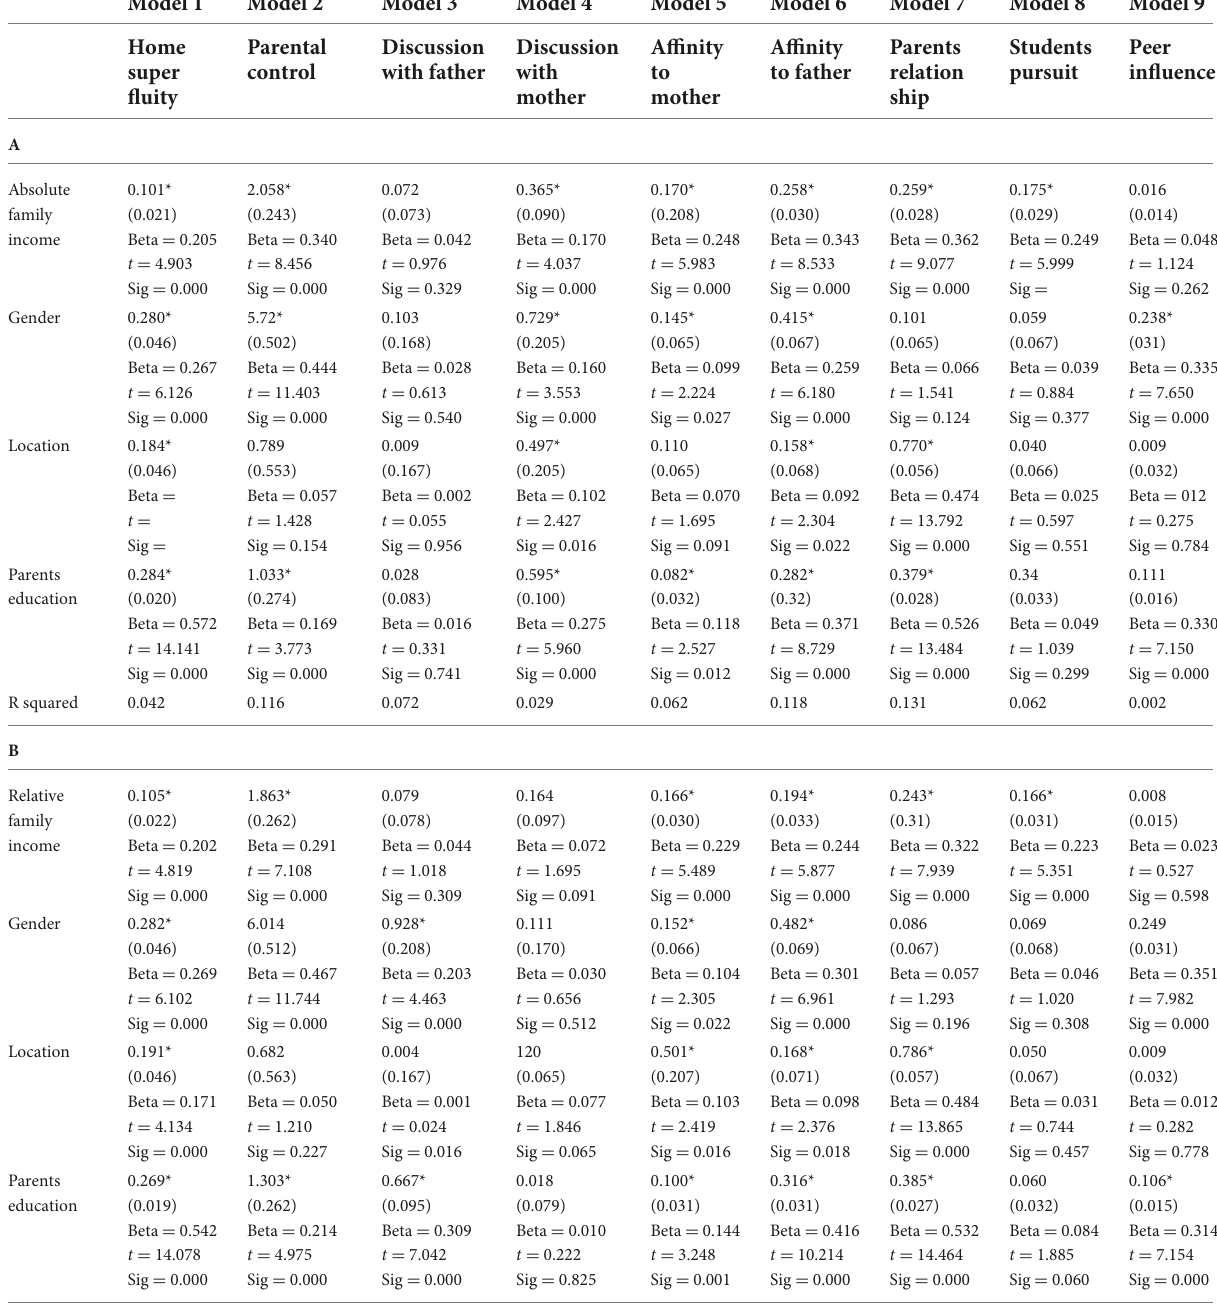
TABLE 3 Regression statistics of the relationship between absolute family income and mediators